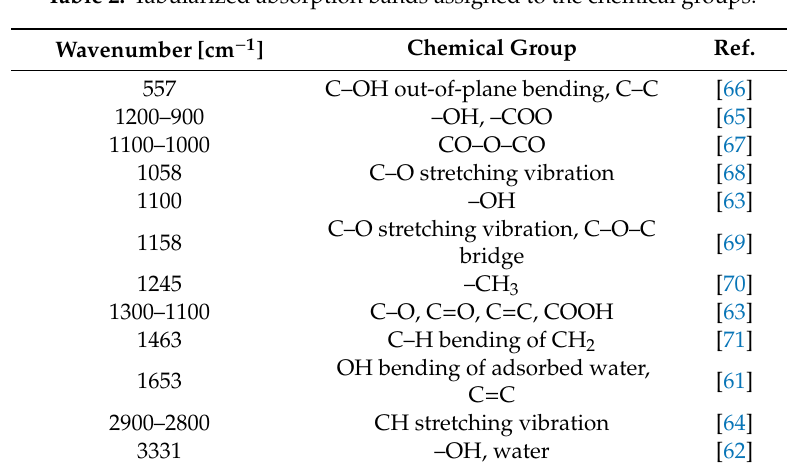
Figure 3. FT-IR spectra of the cellulose fibers that were dried for 45, 90, 180, and 1440 min at 100 °C. Characteristic absorption bands: 3334 cm − 1 (O–H, water), 2894 cm − 1 (C–H), 1200–900 cm − 1 (O–H, C–O, Table 2. Tabularized absorption bands assigned to the chemical